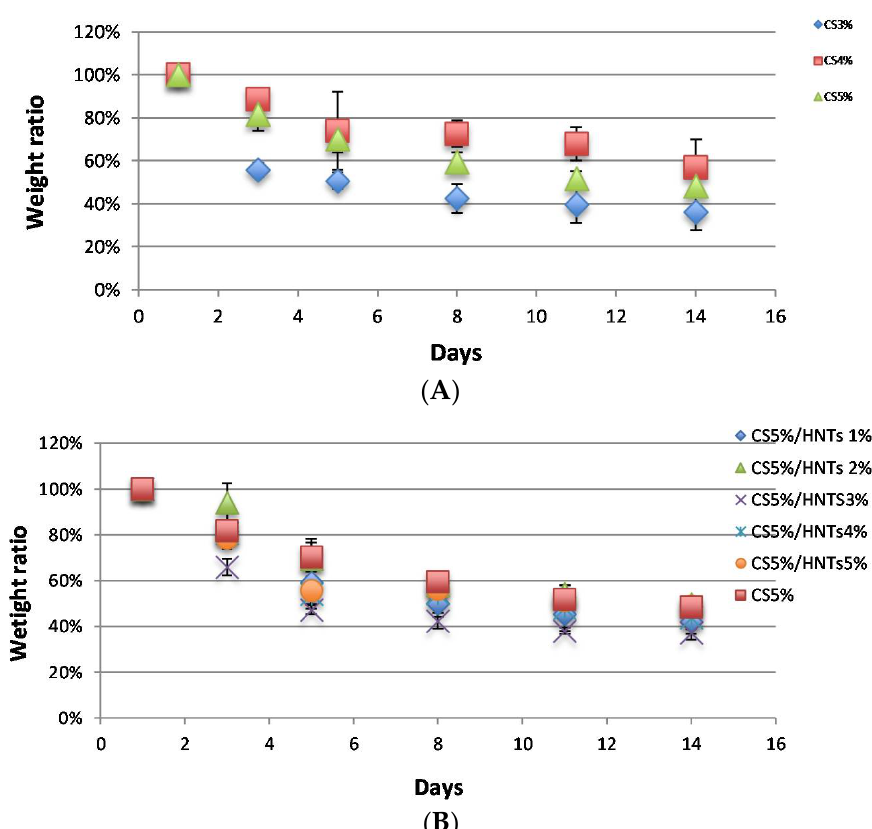
Figure 2. Biodegradability of CS and CS / HNTs in a lysozyme solution (1 mg / mL). ( A ). The weight ratio of hydrogel beads consisted of pure chitosan (3%–5%). ( B ). The weight ratio of hydrogel beads consisted of 5% CS with di ff erent ratios of HNTs (1%–5% wt. / wt.).